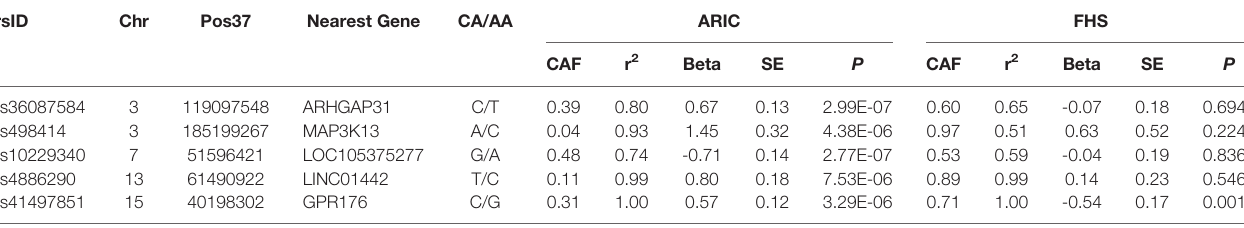
TABLE 2 | Loci reaching suggestive signi fi cance level (P<1E-5) in ARIC.